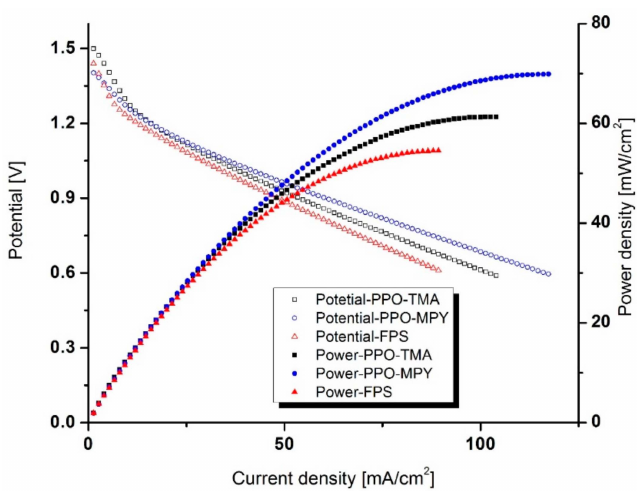
Figure 8. Polarization characteristics of the cells with various separators of PPO–MPY, PPO–TMA, and filter paper-based separator (FPS).